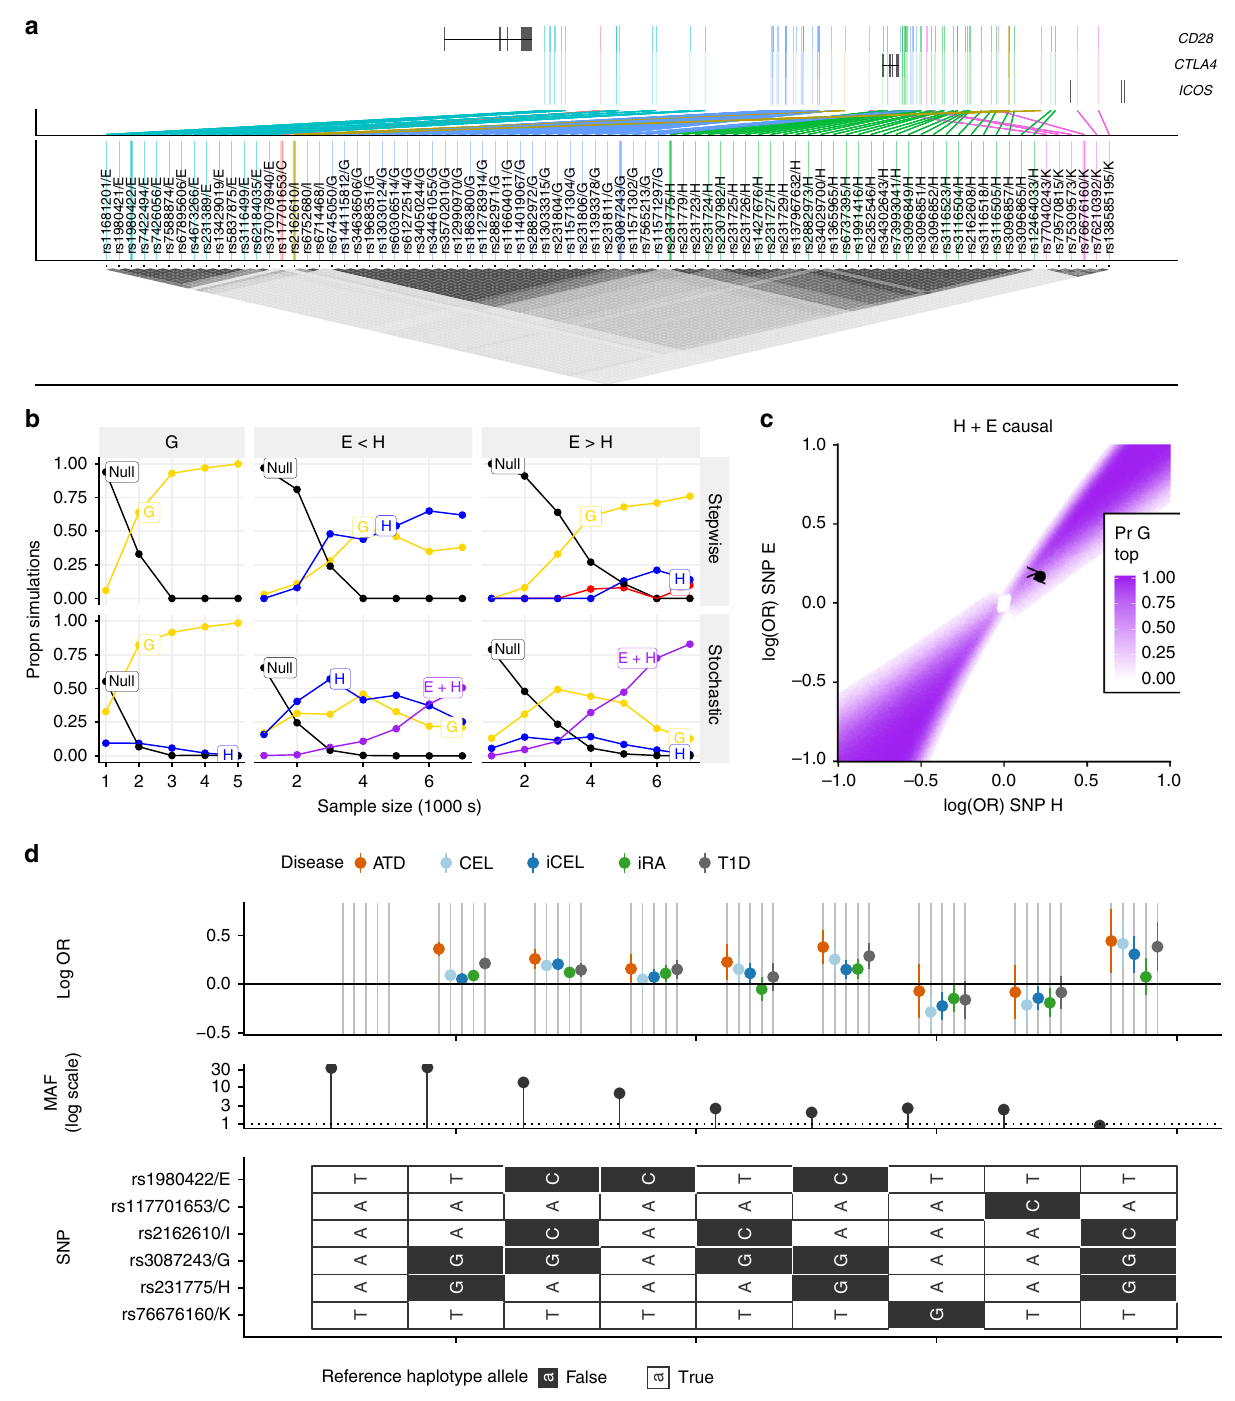
Fig. 5 Analysis of chromosome 2q region containing CTLA4 . a Map showing positions of SNPs (GRCh37) colour coded by SNP group. SNPs in the same group are in high LD. b Comparison of stepwise and stochastic search applied to simulated data. Causal variants were simulated as follows: G: causal variant G, OR = 1.25; E < H and E > H causal variants E + H, E < H:OR E = 1.19, OR H = 1.24 (observed in T1D data); E > H: OR E = 1.24, OR H = 1.19. Possible models include E (red), G (yellow), H (blue), E + H (purple) and null (black); any other models are grouped together as grey. The y -axis shows the proportion of simulations in which the stepwise approach chose the indicated model (adding SNPs while p < 10 -6 ) or the average posterior probabilities for each model for the stochastic search approach. Sample size ( x -axis) is the number of cases and controls. c Assuming E and H are causal, this plot shows the probability that G has the smallest p-value as a function of the effect sizes (log odds ratios) at E and H. The estimated effects for E and H from T1D data are shown by a point, and the simulations from b by < and > for E < H and E > H conditions, respectively. d Haplotype analysis of SNP groups with support in any analysis. Each row represents one SNP, with possible alleles colour coded according to major or minor. Each column is a haplotype — a speci fi c combination of alleles across all SNPs — with frequency in UK controls and effect on disease risk (log OR + 95% CI). MAF is shown as a percentage on a log scale to allow frequencies of rarer haplotypes to be distinguished. Source data for b are provided in Supplementary Tables 5,